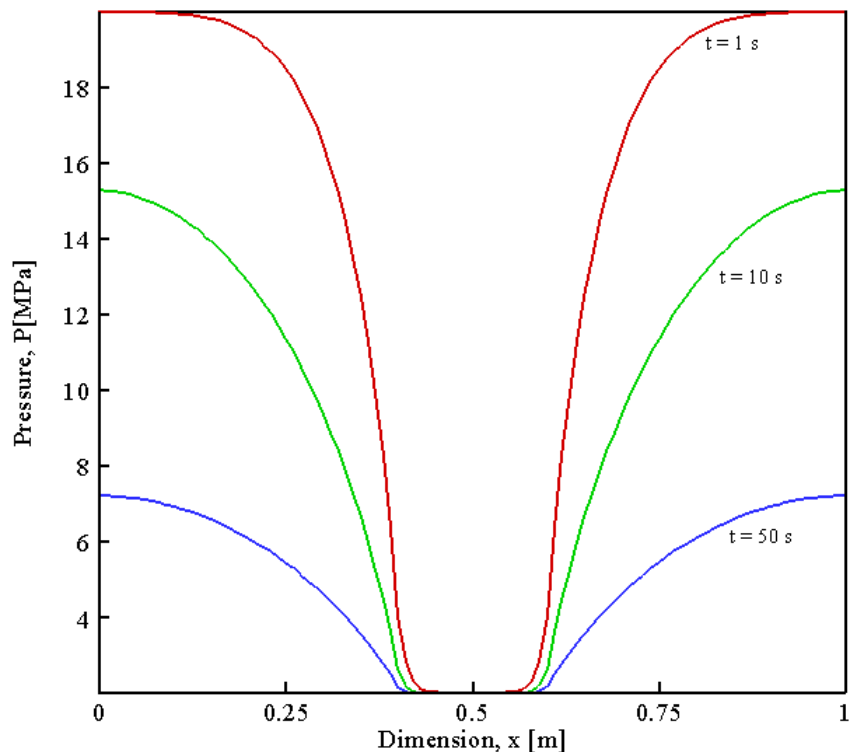
Figure 8. Water saturation distribution w S versus dimension x at the different moments of time t = 1, 10, 50s in the three-phase flow.